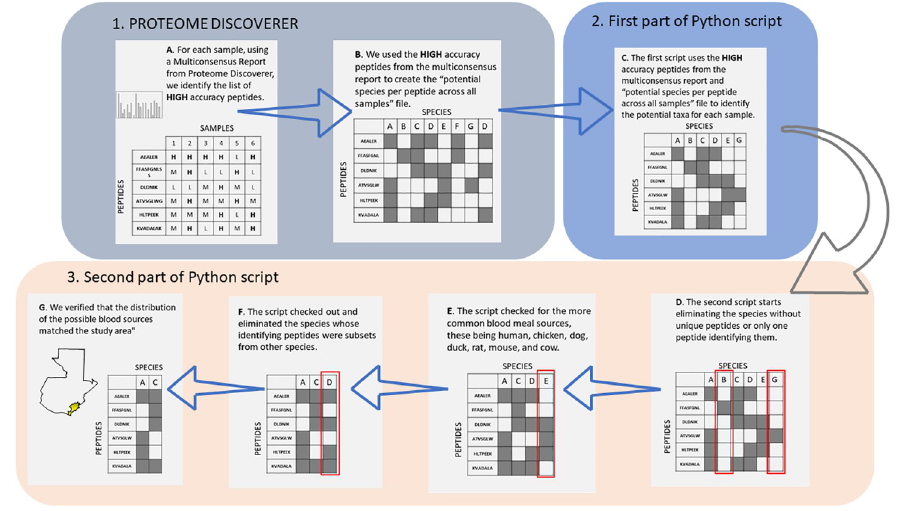
Fig 1. Graphic representation of the workflow for peptide taxonomic identification and principal blood sources